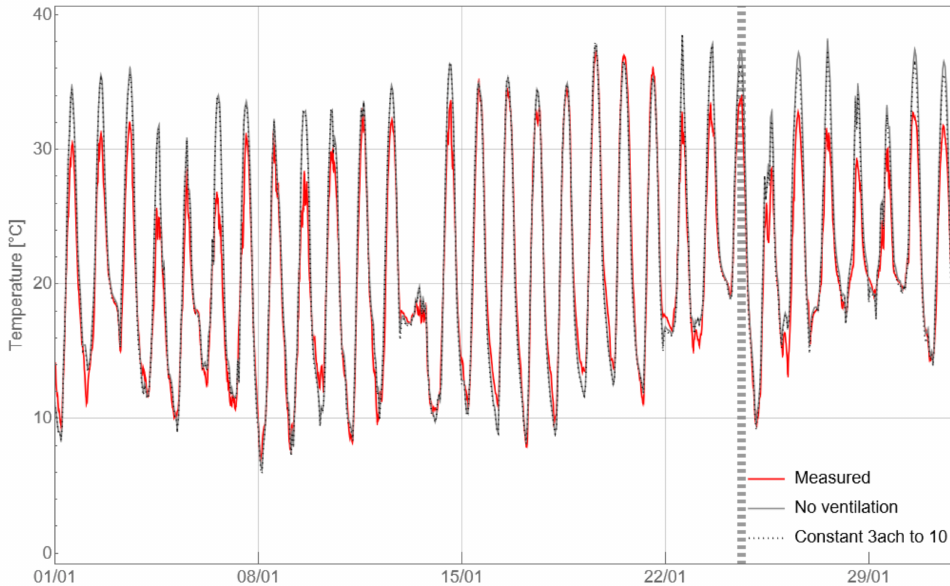
Figure 9. Results from the WUFI ® 2D simulation—temperature of the roof cavity air simulated for no ventilation and ventilation boosting from 3 ach to 10 ach (daytime, 3 ach otherwise) after the fan is